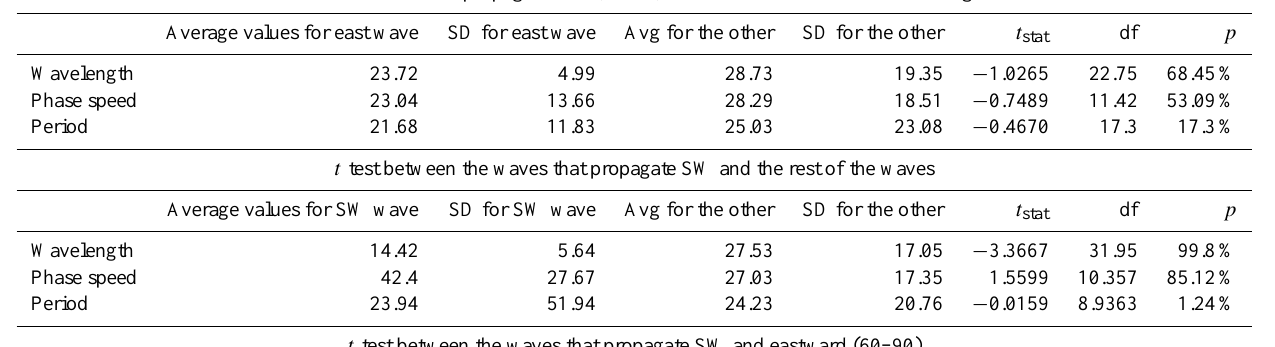
Table 1. Result of the t test; average (Avg), standard deviation (SD), t test statistic ( t stat ), df and p stands for average, standard deviation, test statistic, degree of freedom and p value respectively. For the average values and the standard deviations, wavelength is in units of km, phase speed in units of ms − 1 , and period in units of minutes.